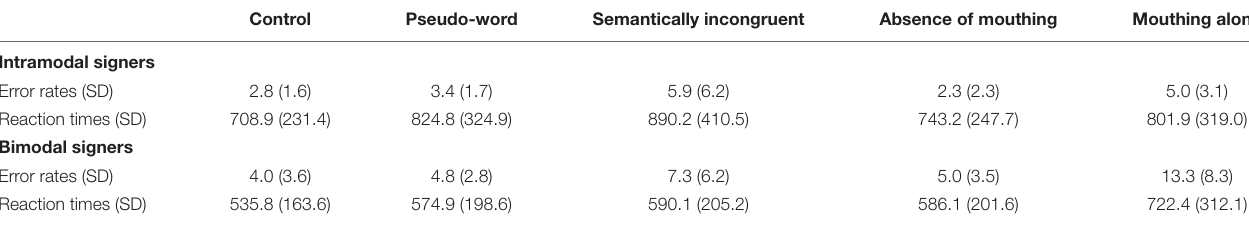
TABLE 2 | Error rates (in percent) and Reaction Times (in ms) in the five conditions according to bilingualism (Intramodal vs. Bimodal). Control Pseudo-word Semantically incongruent Absence of mouthing Mouthing